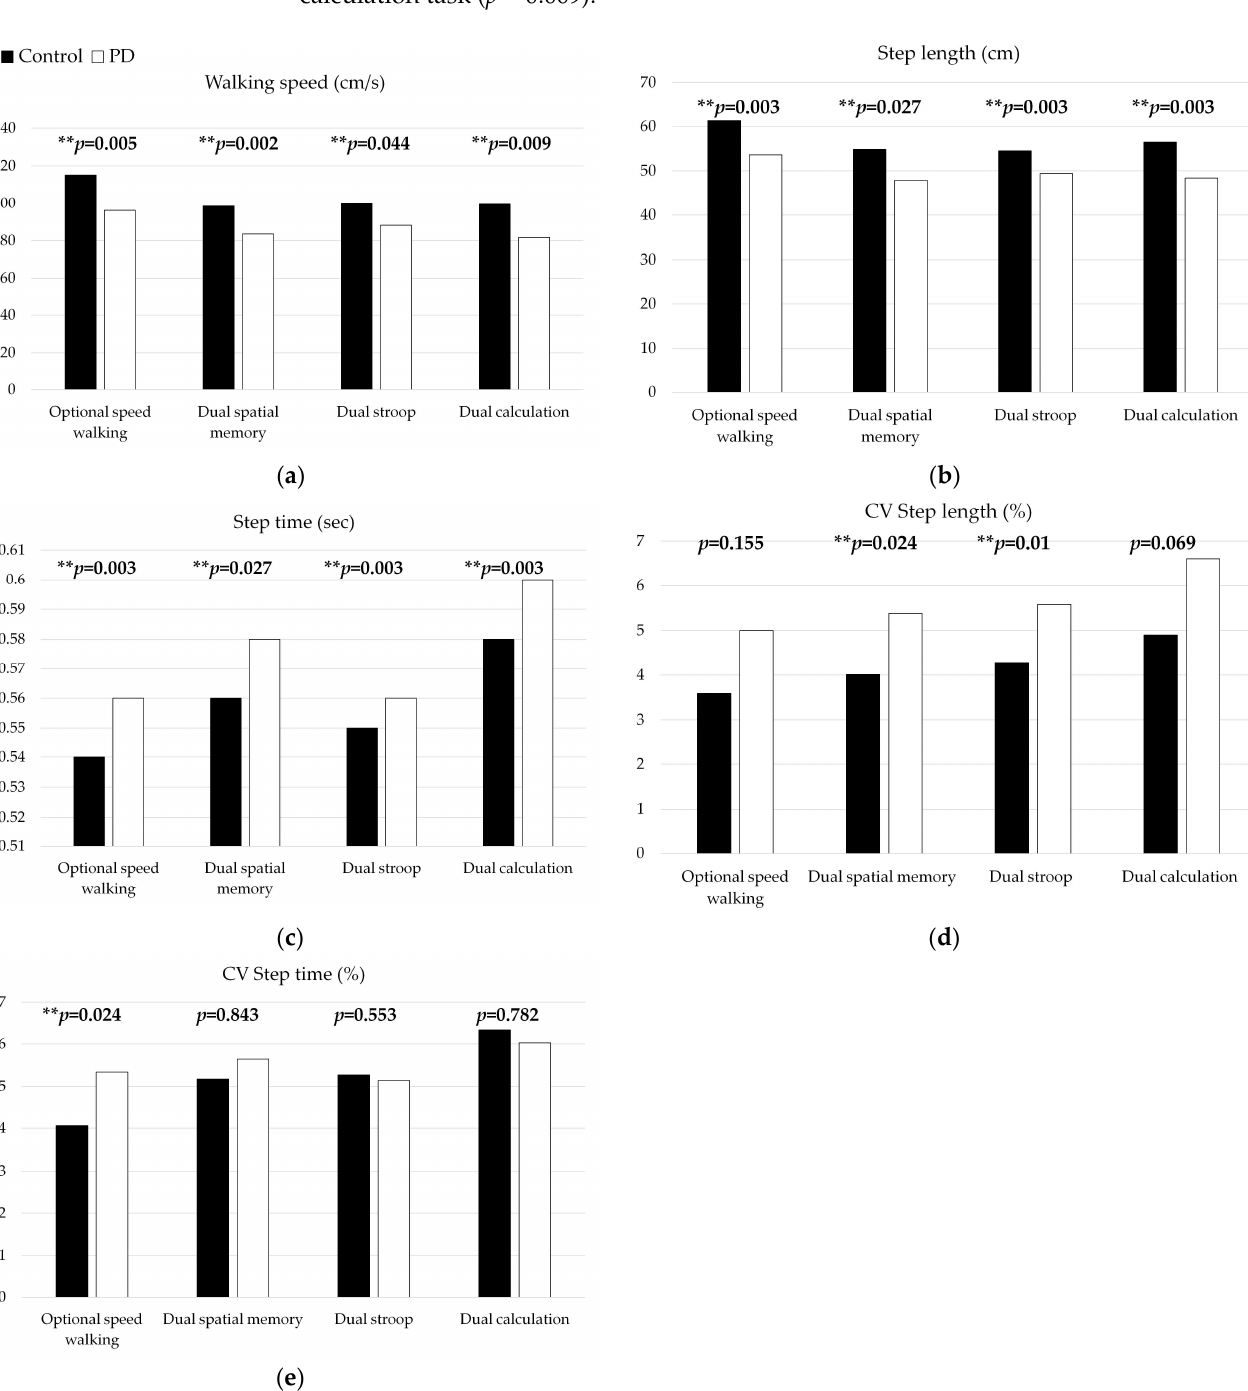
In terms of the step length performance, the Parkinson’s disease group showed sig-